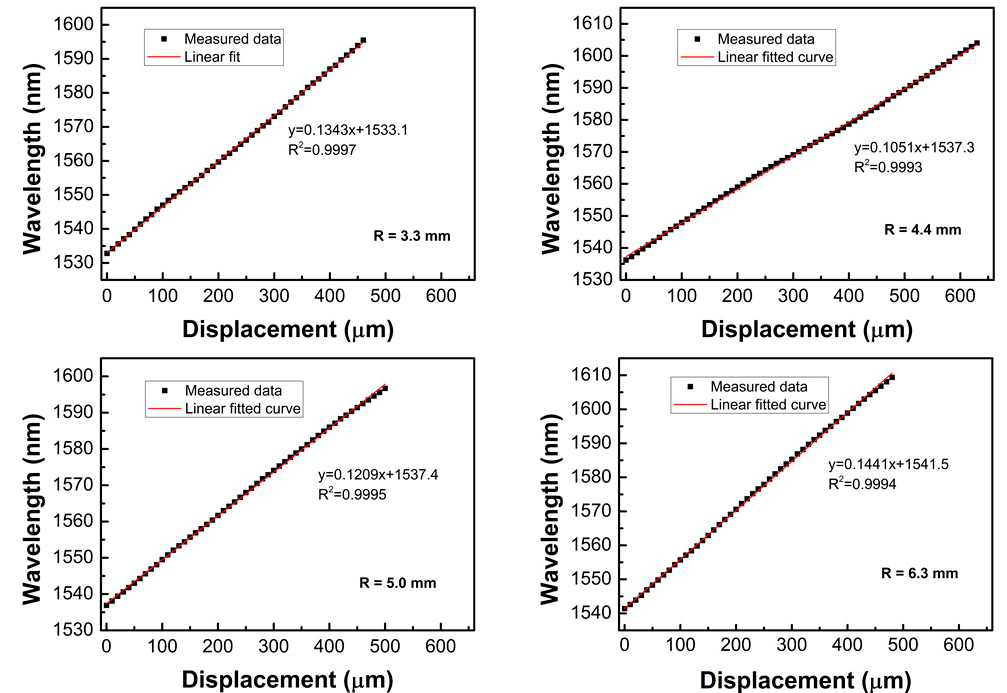
Figure 9. Resonant wavelength dips as a function of displacement for the sensors with different bending radii of 3.3, 4.4, 5.0, and 6.3 mm, respectively.